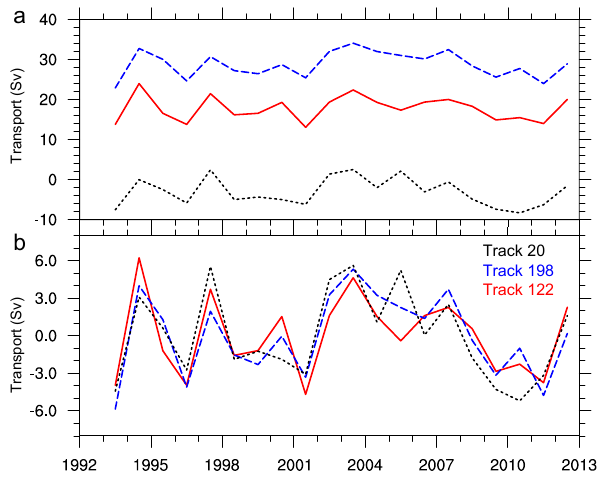
Figure 8. (a) Absolute value of leakage computation from satellite altimetry along three satellite tracks and (b) anomalies with respect to the time average.